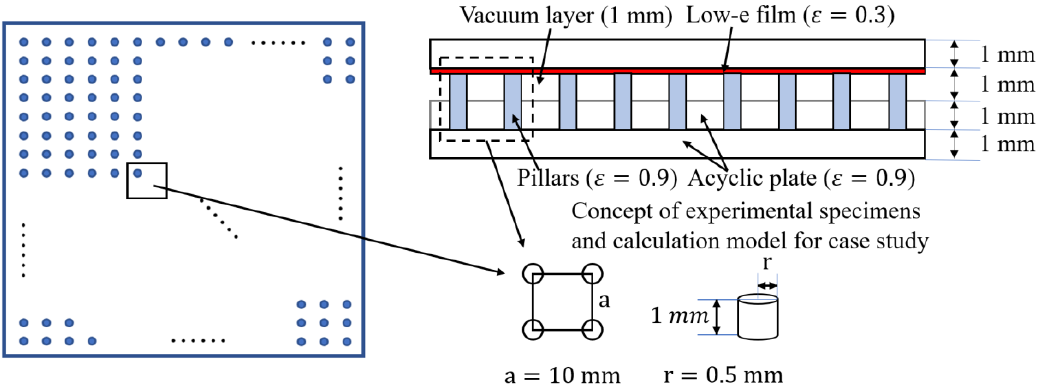
Figure 12. Concept diagram of the VIP specimen and model for the case study.